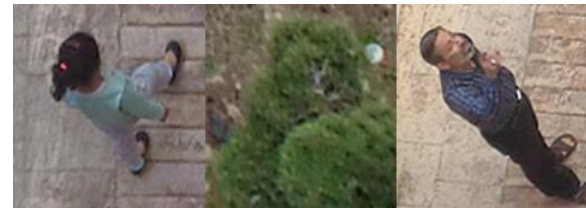
Figure 6. Some examples of Tello images.